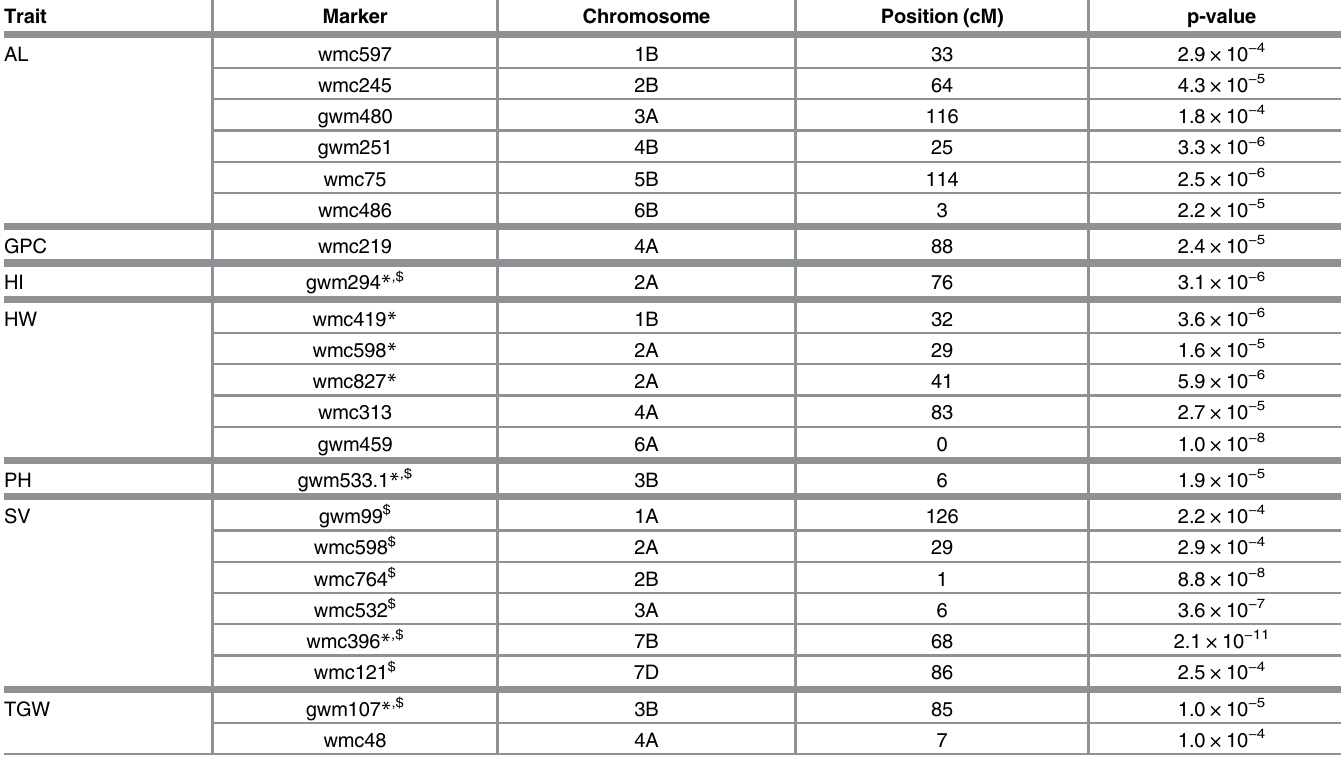
Table 4. Significant marker-trait associations (MTAs) identified through multi-locus mixed model (MLMM) and qualified FDR criteria.